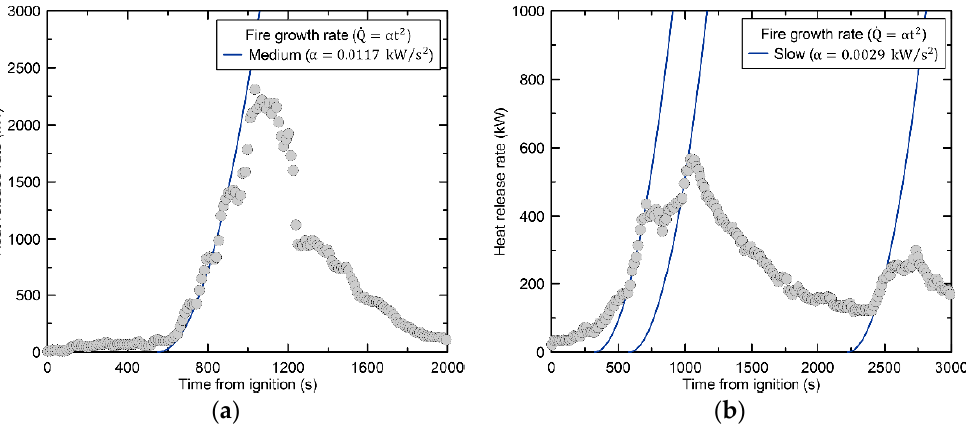
Figure 8. Measured heat release rate and fire growth curve: ( a ) Plastics; ( b ) bags.